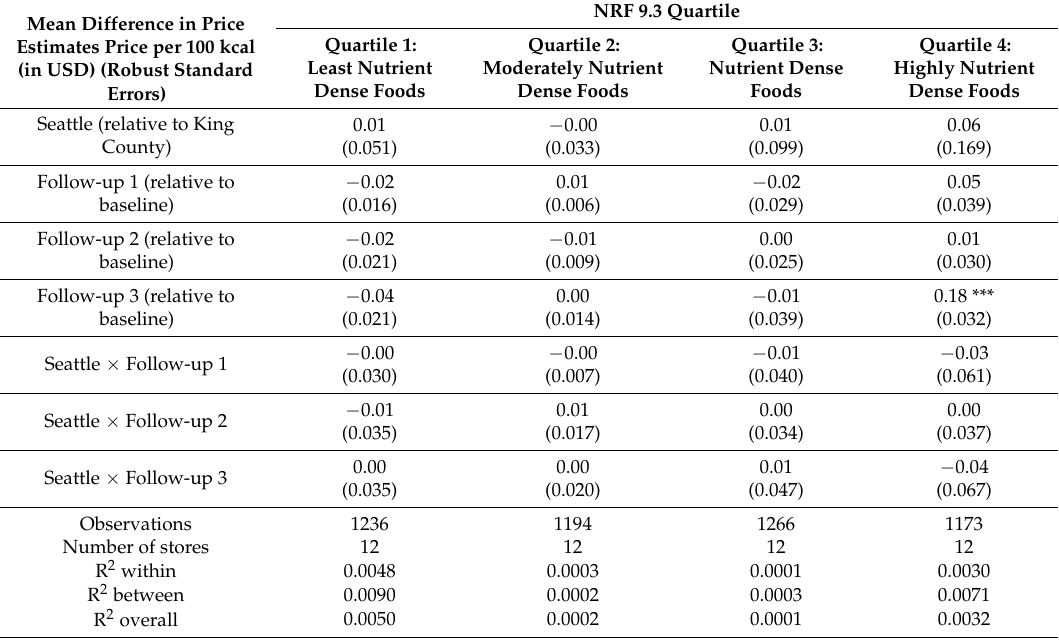
Table 3. Nutrient rich food index 9.3 (NRF 9.3) quartile stratified linear difference-in-differences model results for the mean change in item-level price per 100 kcal across Seattle (‘intervention’) and King County (‘control’) stores and time, from March 2015 to May 2017, following implementation of Seattle’s minimum wage